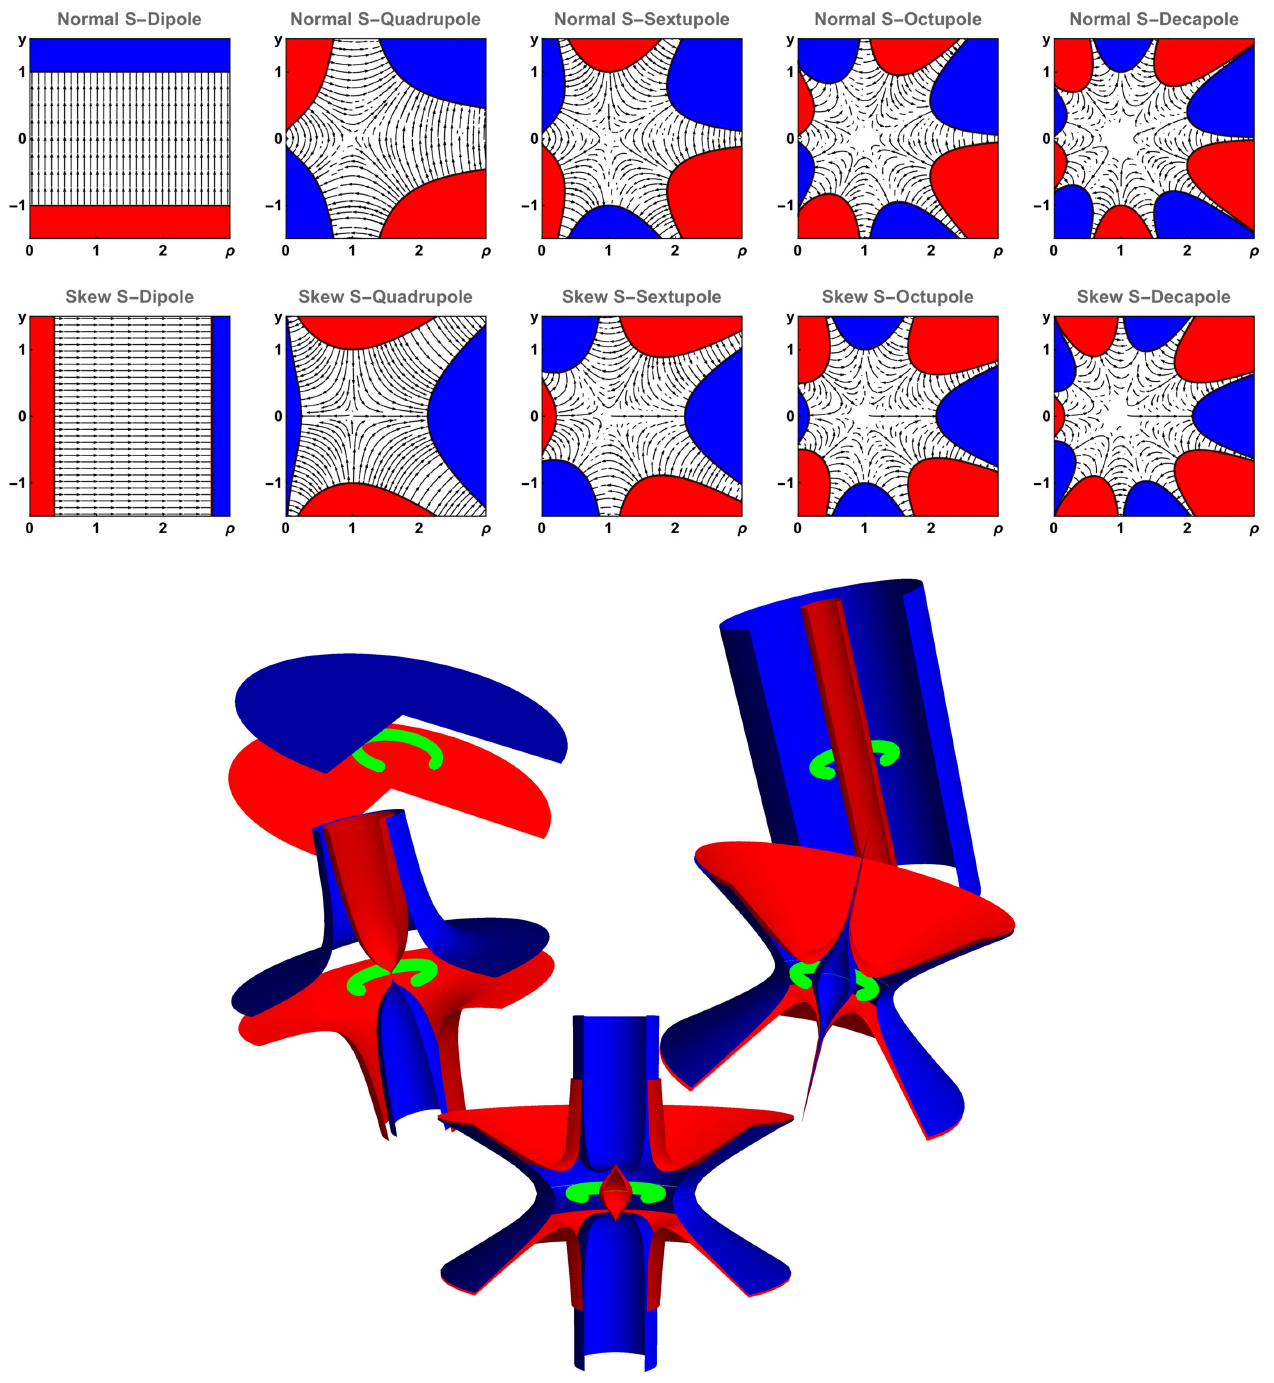
FIG. 4. Normal and skew 2 n -pole magnets in cylindrical coordinates. Each figure shows magnetic (electric) field streamlines and poles ’ shape in the transverse cross section. North (positive electrostatic potential) and south (negative electrostatic potential) poles are shown in red and blue and given by constant levels of ð B ; A Þ ð e Þ n ¼ ∓ const respectively, const ¼ 1 for this example. The bottom plot shows 3D models of sector magnets with θ ¼ 3 π = 2 : normal and skew S-dipoles, normal and skew S- quadrupoles and skew S-sextupole from the left to the right and the top to the bottom respectively. The equilibrium orbit is shown in green